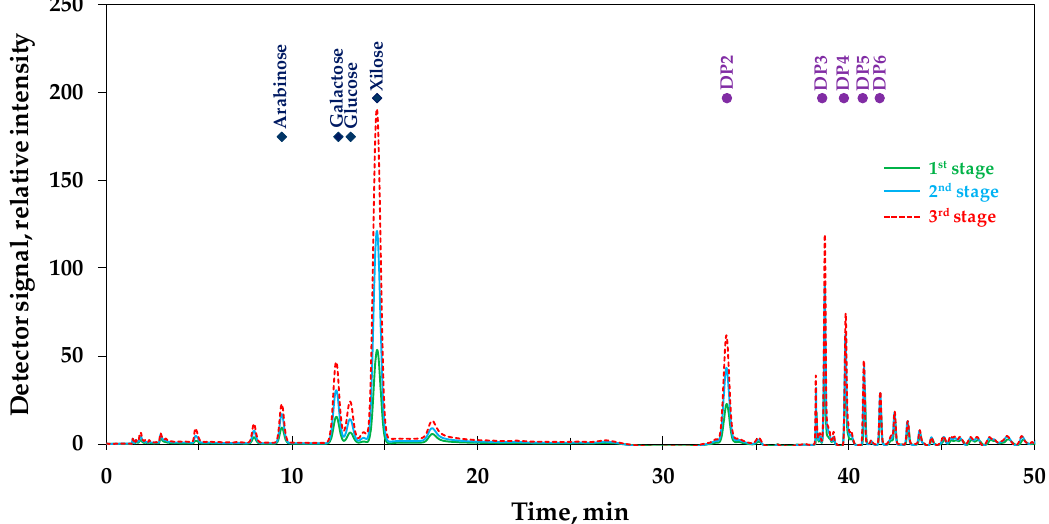
Figure 5. High Performance Anion Exchange Chromatography with Pulsed Amperometric Detection (HPAEC-PAD) data obtained for the liquid phases from the 1st, 2nd and 3rd reaction stages, operating under conditions leading to the maximum concentration of XOs. Table 7. Matrix Assisted Laser Desorption/Ionization Time of Flight Mass Spectrometry (MALDI- TOF) data determined for the liquid stream from the third autohydrolysis results (the m/z values corresponded to the sodium adducts of the identified compounds).